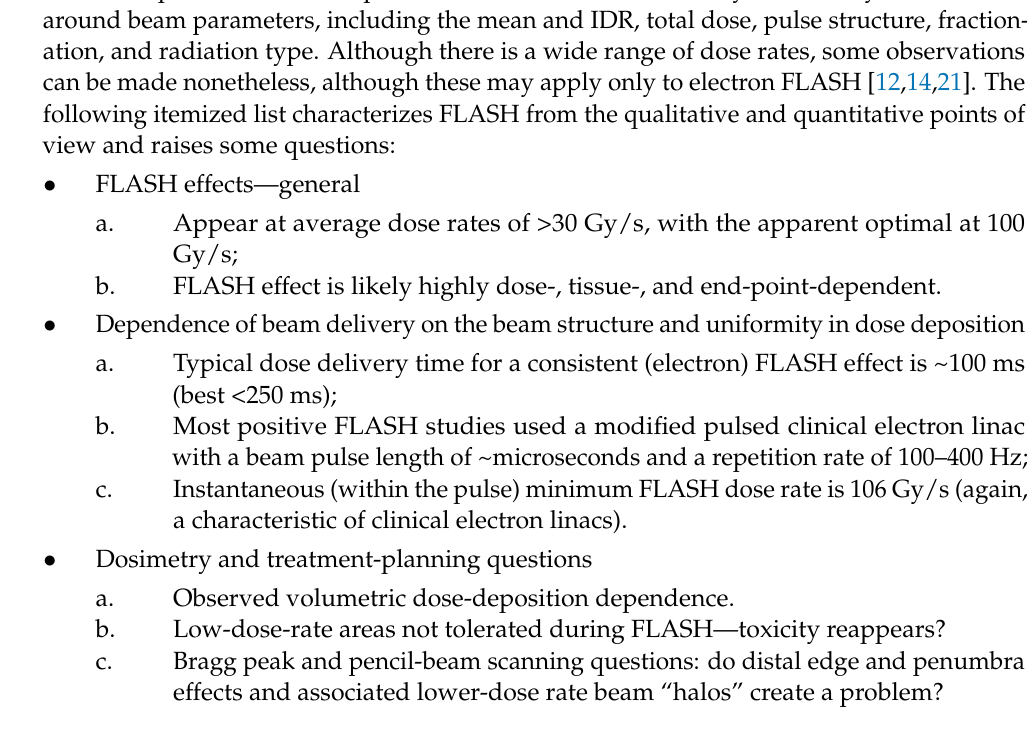
Table 2. Dose delivery requirements for FLASH for protons and ions extrapolated from electron FLASH studies.